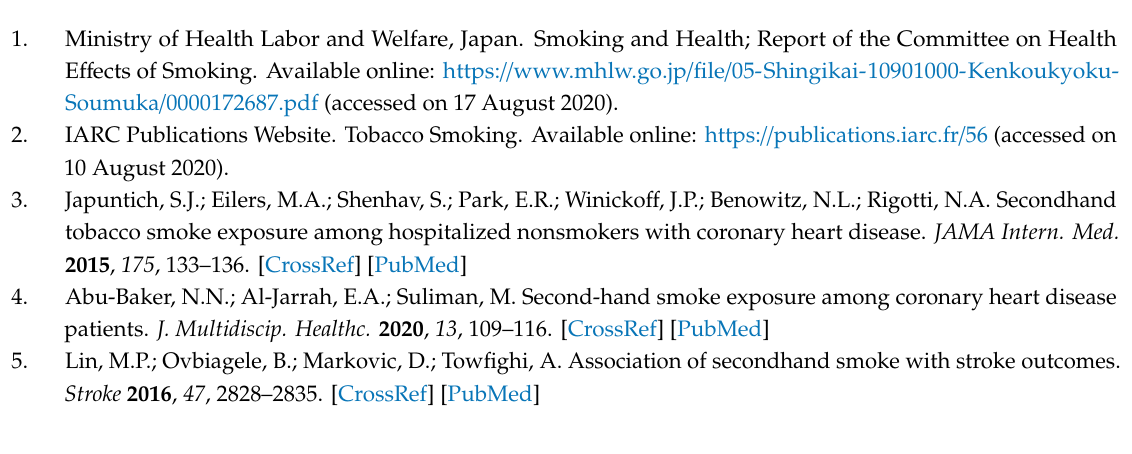
Table S1: STROBE